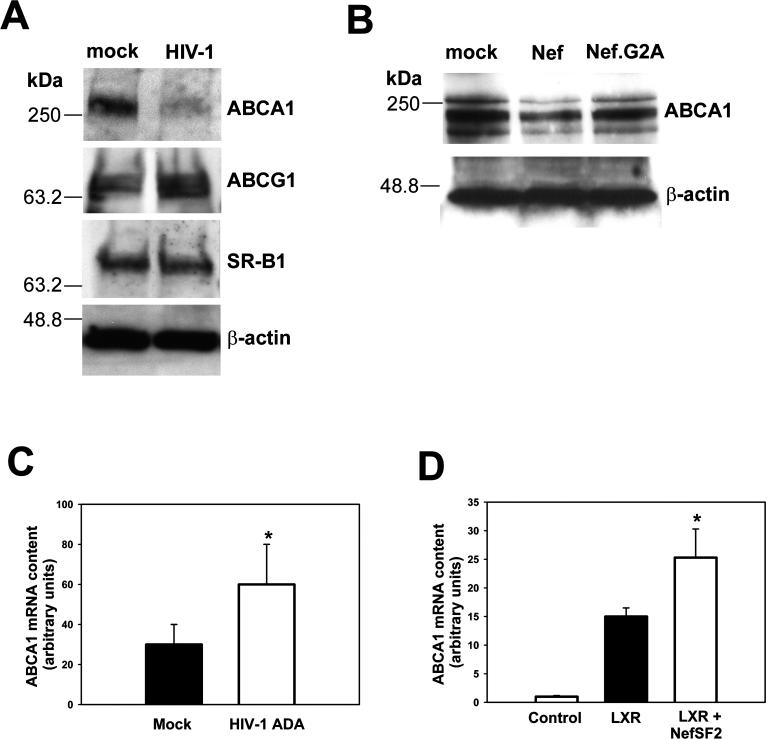
Nef Induces Down-Modulation of ABCA1(A) Human monocyte-derived macrophages were infected with HIV-1 ADA or mock-infected and cultured for 14 d (RT in culture supernatant was 4,000 cpm/μl). ABCA1, ABCG1, SR-B1, and β-actin (loading control) were analyzed by Western blotting.(B) RAW 264.7 cells were transfected with vector expressing HIV-1 SF2-derived Nef (either WT or carrying a G2A mutation) or empty vector (mock). Twenty-four hours after transfection, cells were stimulated with TO-901317 (1 μM) and 24 h later, were analyzed by Western blotting for ABCA1 and β-actin (loading control).(C) ABCA1 RNA from HIV-infected macrophages used for Western blotting in (A) was analyzed by real-time RT-PCR. Results were adjusted according to β-actin signal and are presented in arbitrary units; an asterisk (*) indicates p < 0.01 (versus mock).(D) RNA was extracted from non-activated RAW 264.7 cells (control), mock-transfected RAW cells activated with LXR agonist TO-901317 (LXR), or cells transfected with SF2-derived Nef and activated with TO-901317 (LXR+NefSF2), and analyzed by real-time RT-PCR. Results were adjusted according to 28S RNA signal and are presented in arbitrary units; an asterisk (*) indicates p < 0.01 (versus LXR agonist-treated, mock-transfected cells).